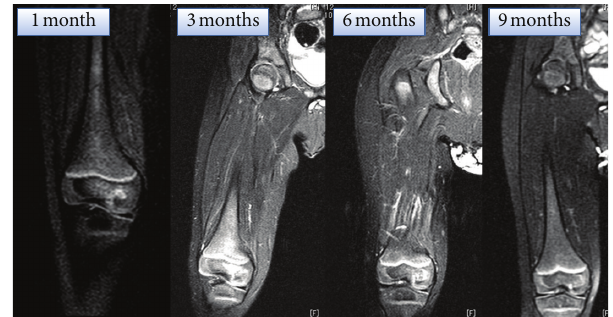
Figure 3: Coronal STIR sequences on repeat MRIs show hyperin- tensity in epiphyseal nucleus until 6 months later. At 9 months, the intensity returns to